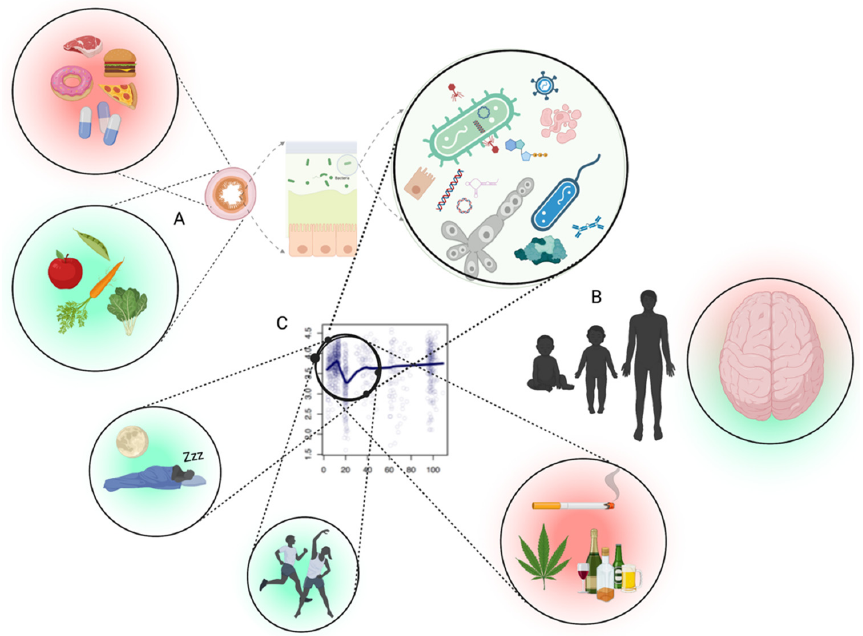
Figure 1. Interface between the gut microbiota and mental health likely depends upon several fac- tors. ( A ) The first being the inputs to the intestinal tract which shape the microbiota accordingly (diet, medication, antimicrobials, etc.). ( B ) Periods where microbiota goes through changes in diver- sity (alpha) occur in healthy people, especially between late teens and early twenties, which likely result in differences of metabolic output which impact brain health. ( C ) The intersection of the ado- lescent brain, combined with a normally fluctuating microbiota of the age group, the promotion of a desirable microbiota through physical activity/exercise and circadian rhythm, and less desirable microbiota using different substances. Part ( C ) adapted from Bian et al., 2017 [12]. Figure created with Biorender (accessed on 29 April 2022).